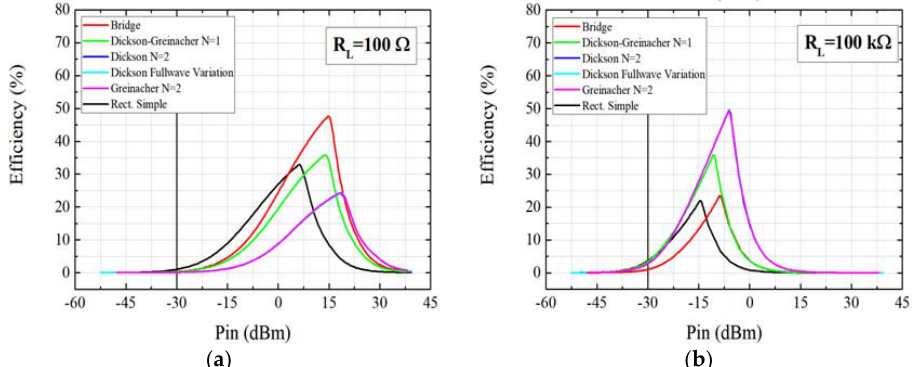
Figure 4. Simulated 𝜂 (cid:3045)(cid:3032)(cid:3030) (𝑃 (cid:3036)(cid:3041) ,𝑅 (cid:3013) ) for 𝑅 (cid:3013) = 100 Ω ( a ) and 𝑅 (cid:3013) = 100 kΩ ( b ).